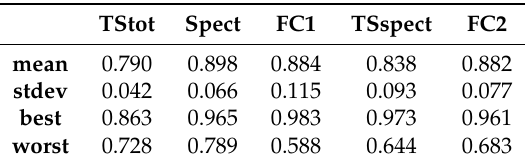
Table A7. Accuracy for narrowband excitation (52kHz to 48kHz); grouped by shapes. Compare also Figure 10a. TStot Spect